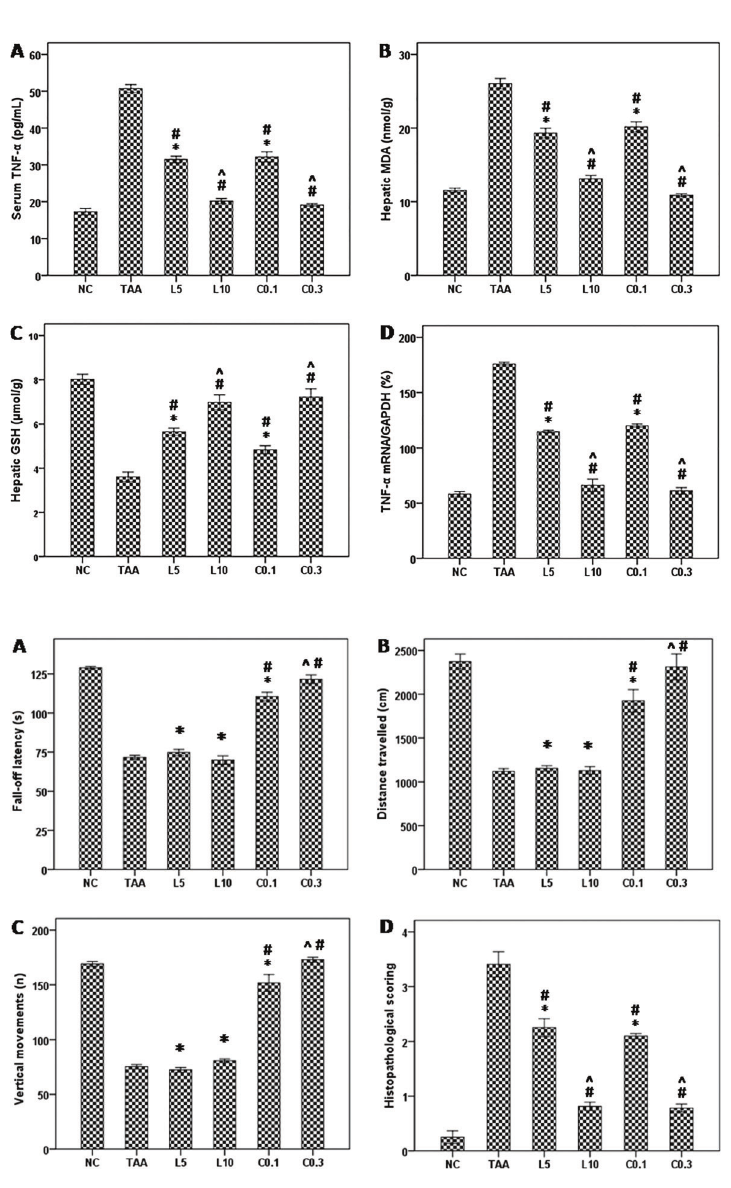
Figure 2. Effects of losartan and candesartan on the levels of: A , serum tumor necrosis factor- a (TNF- a ), B , hepatic malondialdehyde (MDA), C , hepatic glutathione (GSH), and D , hepatic expression of TNF- a mRNA in thioacetamide (TAA)-induced chronic liver failure rats. Losartan (L5 and L10; 5 and 10 mg (cid:1) kg – 1 (cid:1) day – 1 ) and candesartan (C0.1 and C0.3; 0.1 and 0.3 mg (cid:1) kg – 1 (cid:1) day – 1 ) were given for 14 days by gastric gavage.